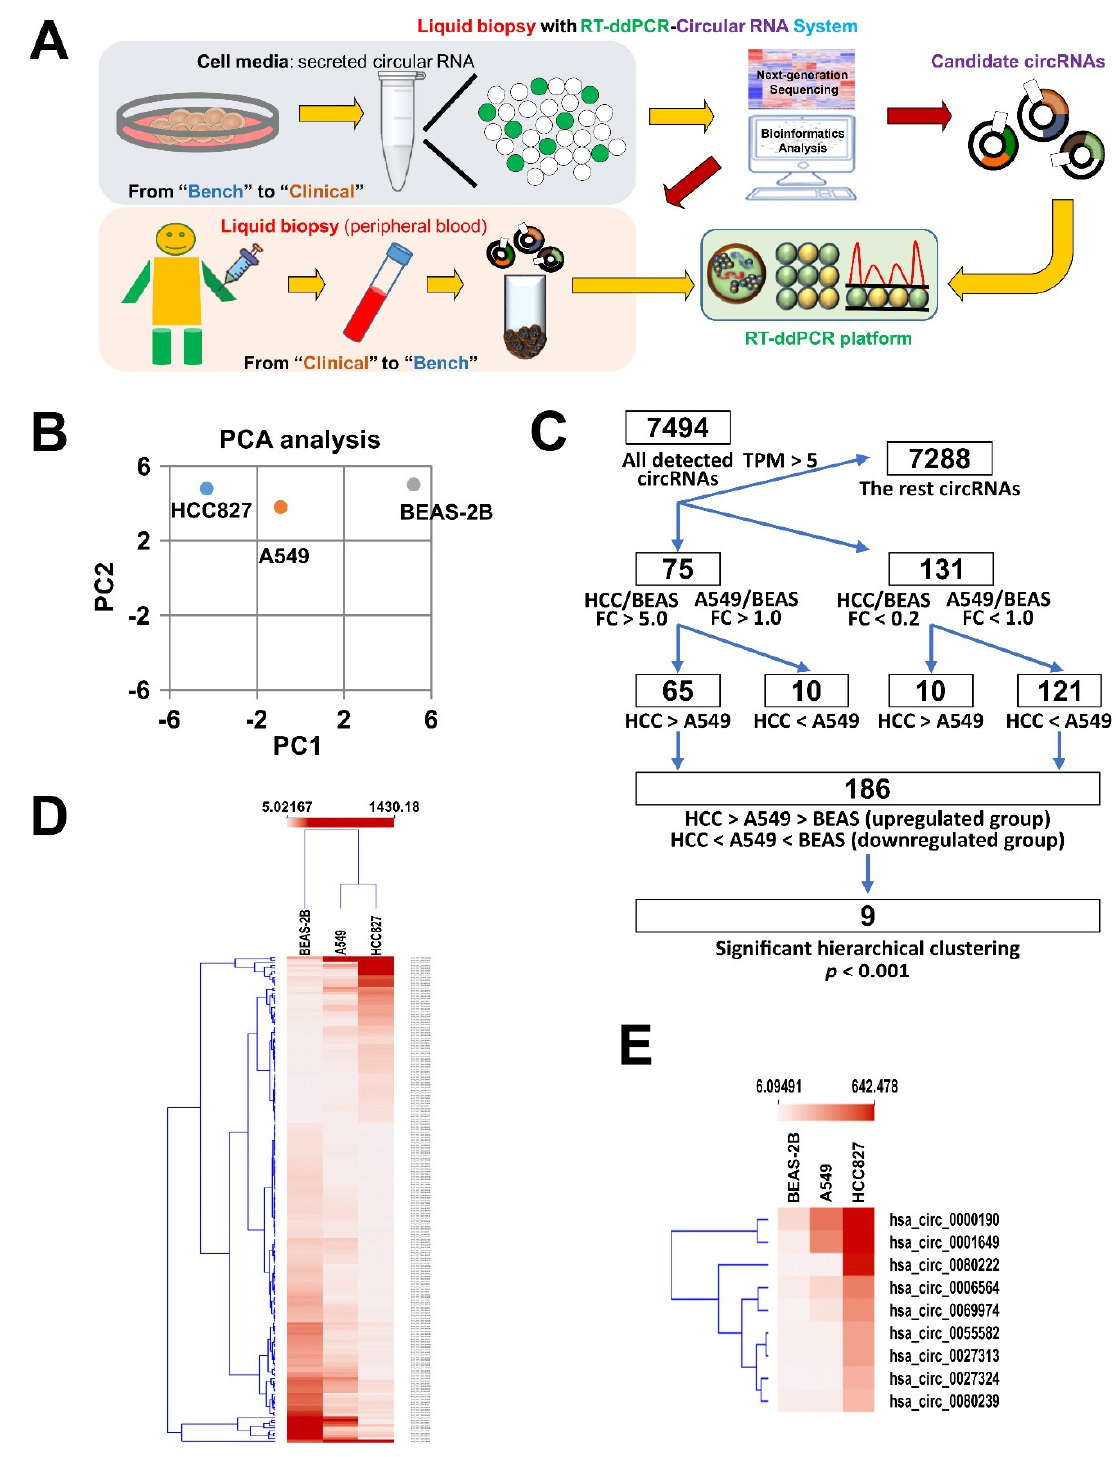
Figure 1. Identification of potential secretory circRNA biomarker candidates using RNA-Seq. ( A ) Descriptive flow diagram of experimental plan to identify potential circRNA biomarkers of LC. ( B ) Principal component analysis (PCA) of circRNA sequencing results of LC cell lines (HCC827 and A549) and normal bronchial epithelial cells (BEAS-2B). ( C ) Flow diagram of RNA-Seq analysis aimed at selecting the best candidates of circRNA LC biomarkers. ( D , E ) Hierarchical clustering heatmap of 189 circRNA candidates ( D ) identified according to the pipeline shown in ( C ) and a subset of 9 circRNAs with the most prominent fold changes ( E ).